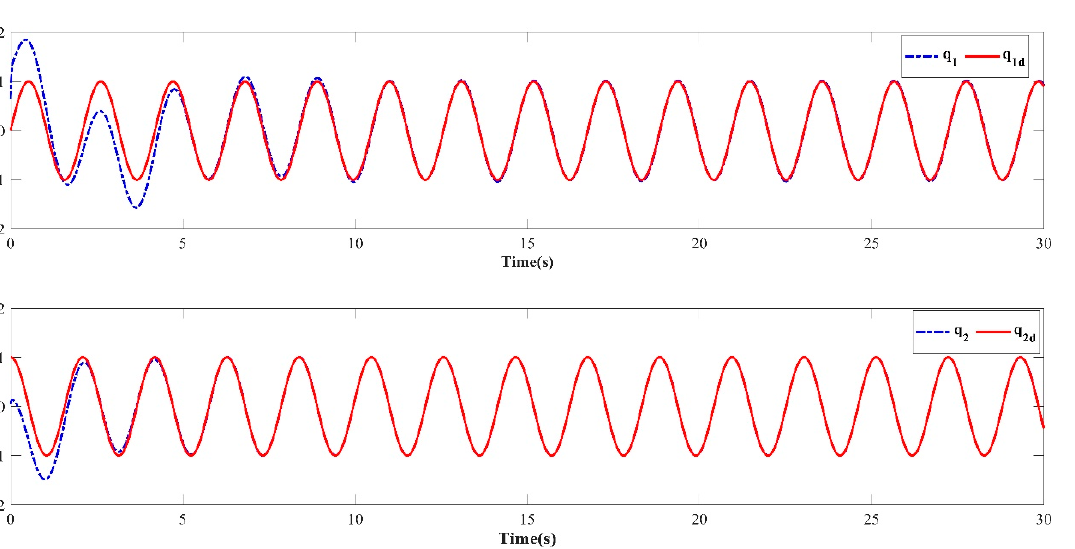
Figure 4. Learning trajectory in the third iteration.